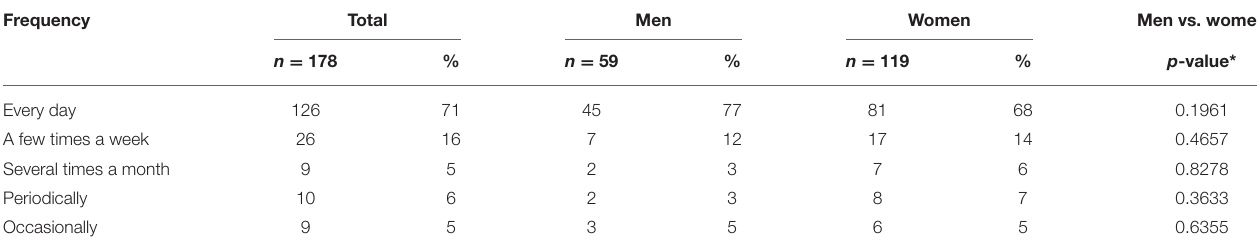
TABLE 2 | Frequency of food supplement consumption during the 12 months prior to the